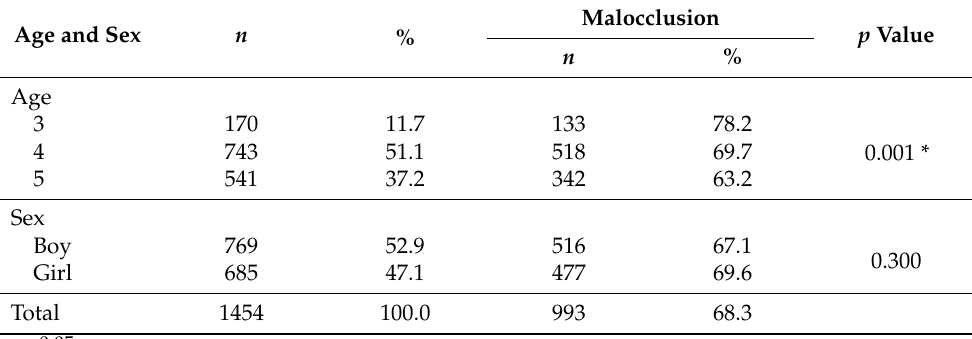
Table 1. Prevalence of malocclusion in 3–5-year-old children in Huizhou, China. Age and Sex n